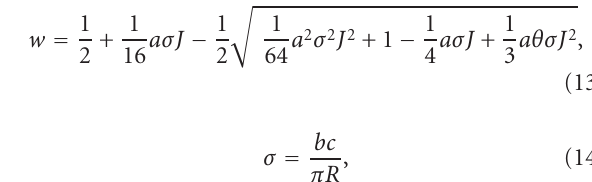
Figure 8: Optimum w versus C D